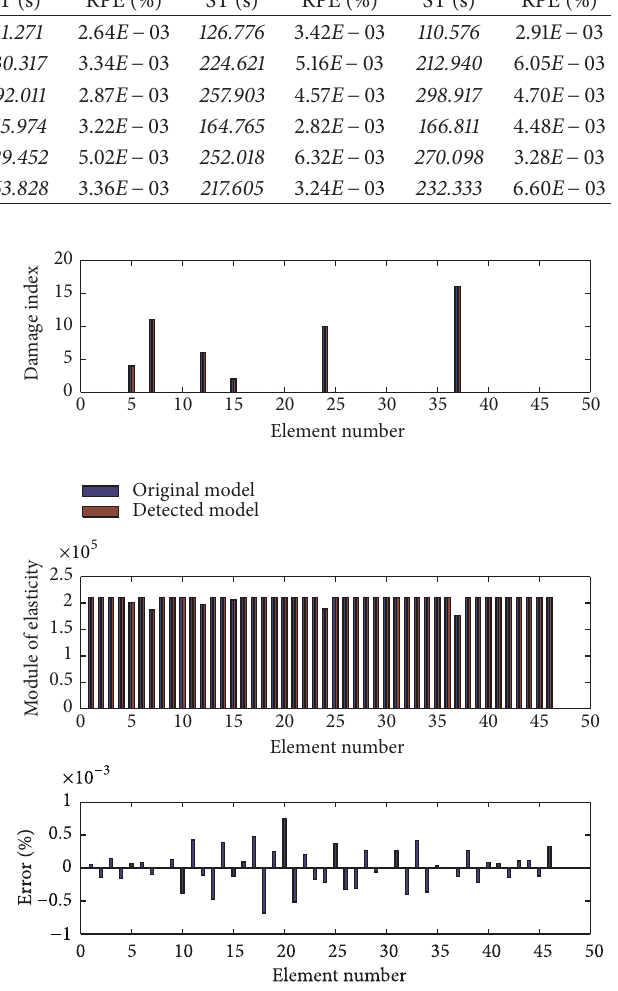
Figure 6: Detection of damage location and amount in elements 5, 7, 12, 15, 24, and 37 and distribution of error in different elements with ADM